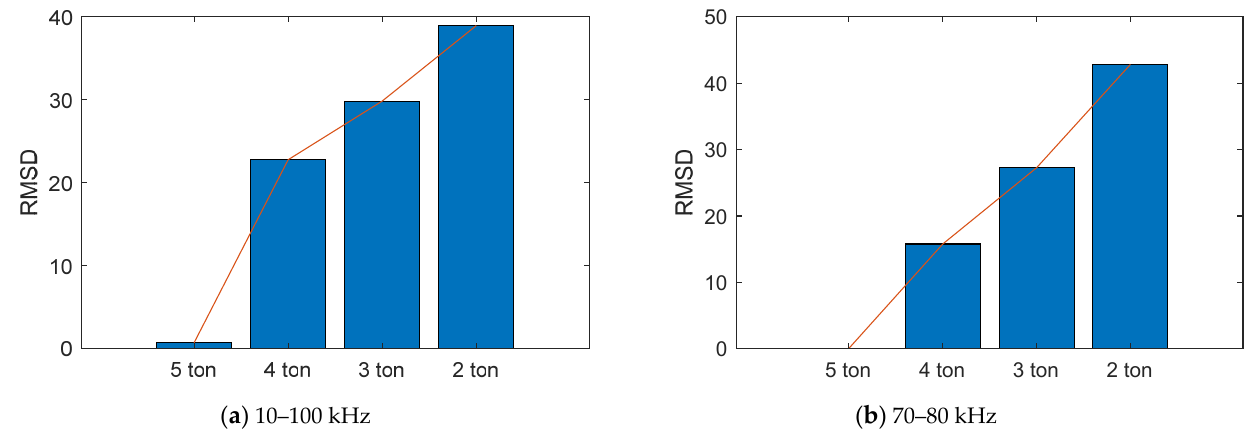
Figure 15. The RMSD index of the electromechanical impedance of the single-point mount PZT interface.